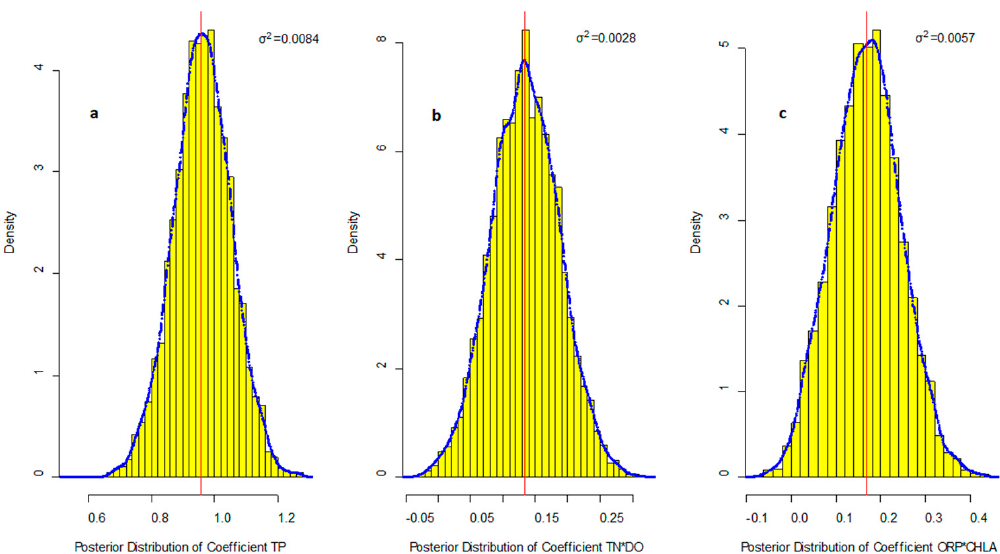
Figure 2. The posterior distribution of coe ffi cients for Fe(II). The blue dotted line is the kernel density estimation for the coe ffi cients, the solid red line is the posterior mean value of coe ffi cients, σ 2 is the posterior variance of coe ffi cients, and yellow bars are the histogram of the density of posterior coe ffi cients; ( a ) total phosphorus (TP) coe ffi cient; ( b ) TN × dissolved oxygen (DO) coe ffi cient; ( c ) oxidation reduction potential (ORP) × chlorophyll a (CHLA) coe ffi cient. The coe ffi cients of TP exhibit the lowest posterior uncertainty with coe ffi cient of variation (CV) 0.10. The posterior uncertainty of the ORP × CHLA interaction e ff ect on Fe(II) was higher than that of interaction e ff ect of TN × DO. The CV of the two interaction e ff ects were 0.45 and 0.39,